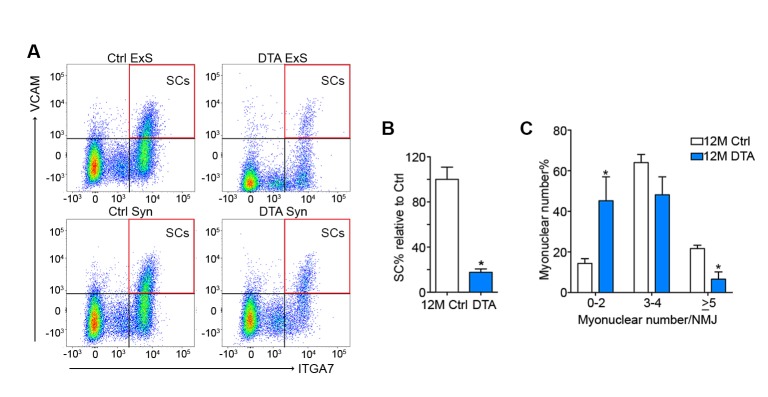
SCs are depleted in P7DTA diaphragms, accompanied by reduction in the size of post-synaptic myonuclear clusters.(A) Representative FACS plots of cells isolated from 12-month-old Ctrl and P7DTA synaptic and extra-synaptic diaphragms. Red boxes represent the gate for the SC population. (B) Quantification of FACS-purified SC percentage of total events relative to Ctrl samples demonstrates SC depletion efficiency in the diaphragm. (C) Percentage distribution of diaphragm NMJs based on number of post-synaptic myonuclei. *p<0.05 compared to Ctrl, unpaired Student’s t-tests. n = 3 (Ctrl) or 5 (P7DTA) mice (B); n = 3 mice per group, 20 NMJs/mouse (C).